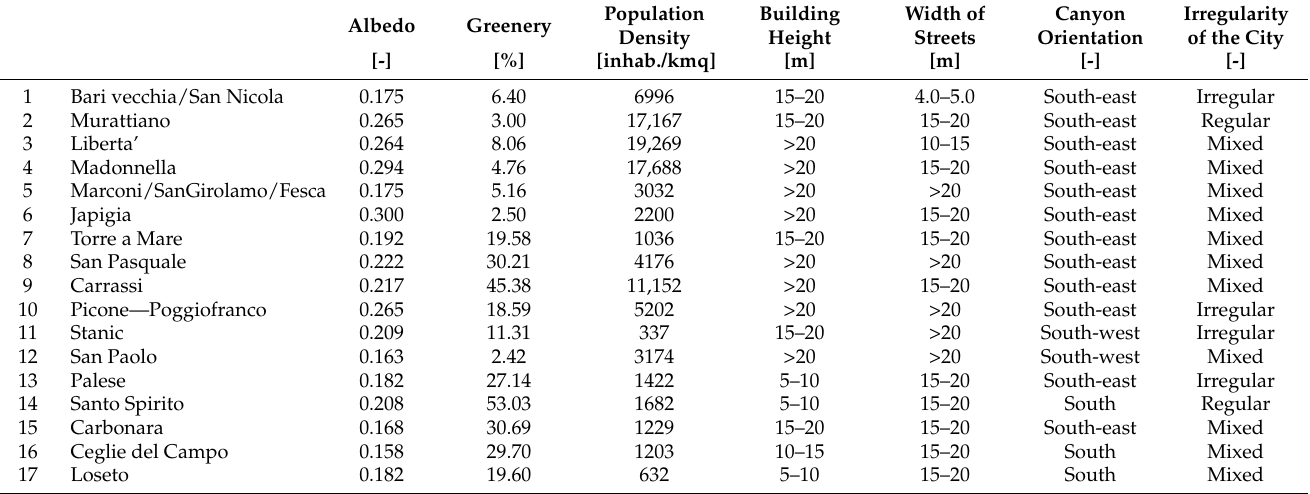
greenery (less than 5%); Carrassi and Santo Spirito have the higher percentage of greenery